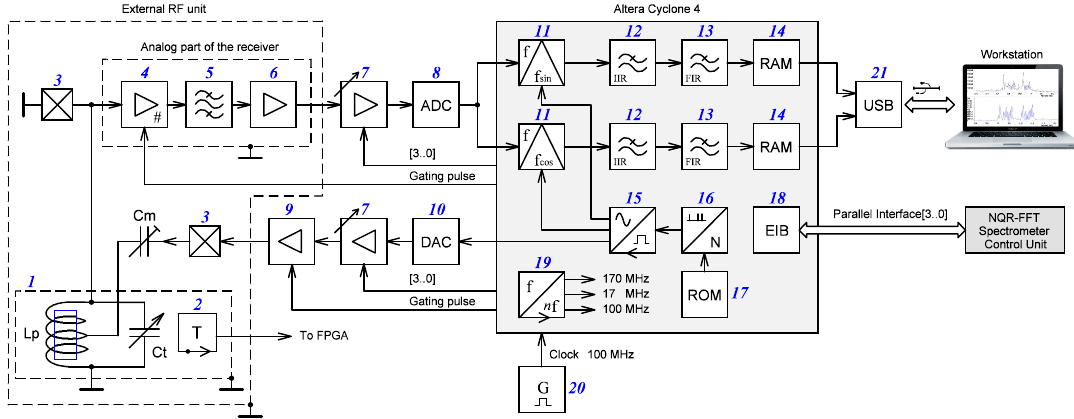
Figure 1. Block diagram of the measuring setup for the study of nuclear quadrupole resonance (NQR): ( 1 ) NQR sensor unit; ( 2 ) digital thermometer; ( 3 ) diode limiters; ( 4 ) gated RF amplifier; ( 5 ) bandpass filter; ( 6 ) matching amplifier; ( 7 ) variable gain amplifiers; ( 8 ) analog to digital converter; ( 9 ) RF transmitter; ( 10 ) digital to analog converter; ( 11 ) double balanced mixers; ( 12 ) integrator-comb filters; ( 13 ) compensating filters; ( 14 ) random access memory; ( 15 ) direct digital synthesizer; ( 16 ) multi-pulse generator; ( 17 ) read only memory; ( 18 ) control module driver; ( 19 ) phase-locked loop; ( 20 ) crystal oscillator; ( 21 ) universal serial bus.